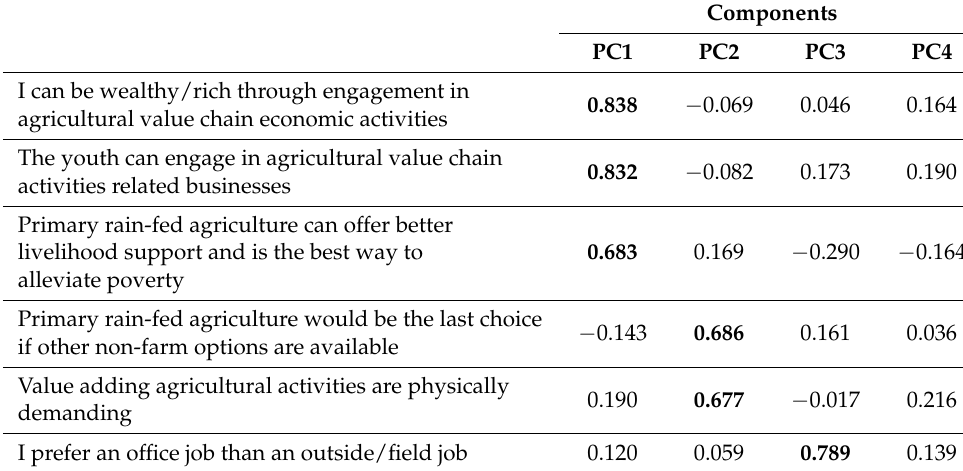
Table 3. Rotated component